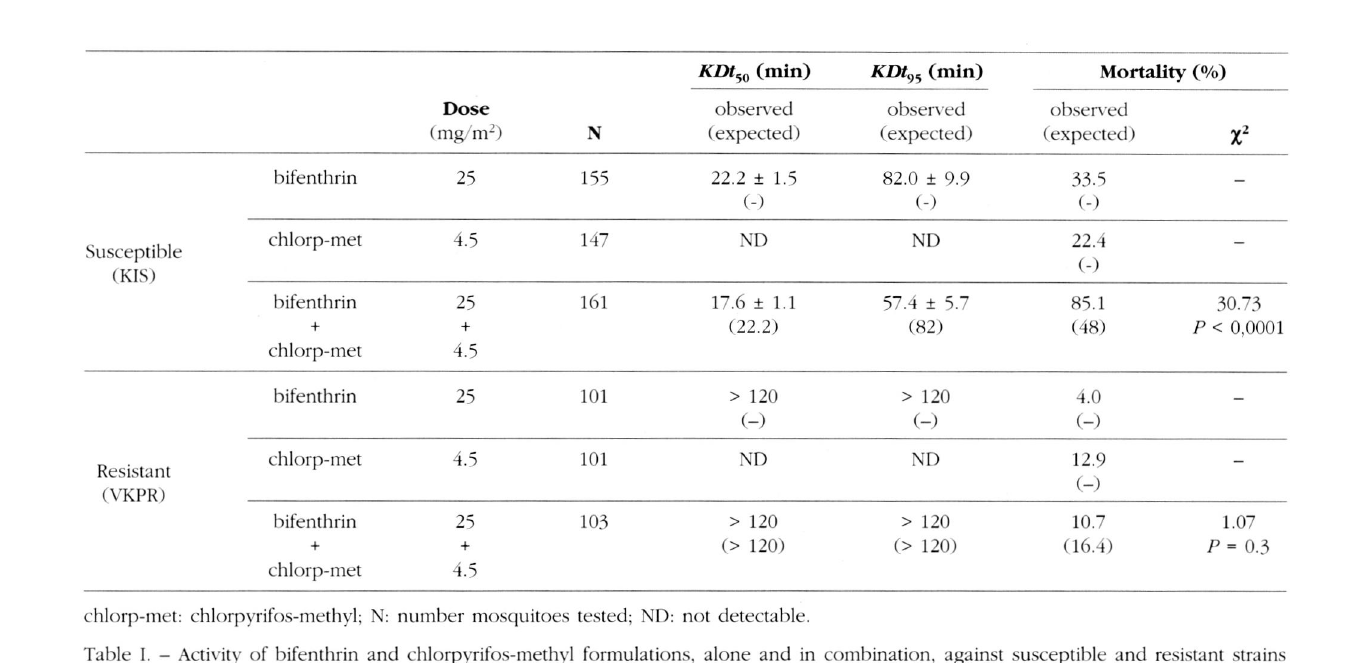
Table I. - Activity of bifenthrin and chlorpyrifos-methyl formulations, alone and in combination, against susceptible and resistant strains of Anopheles gambiae (KDt and KDt with their 95 % confidence intervals and mortality rates). 50 95